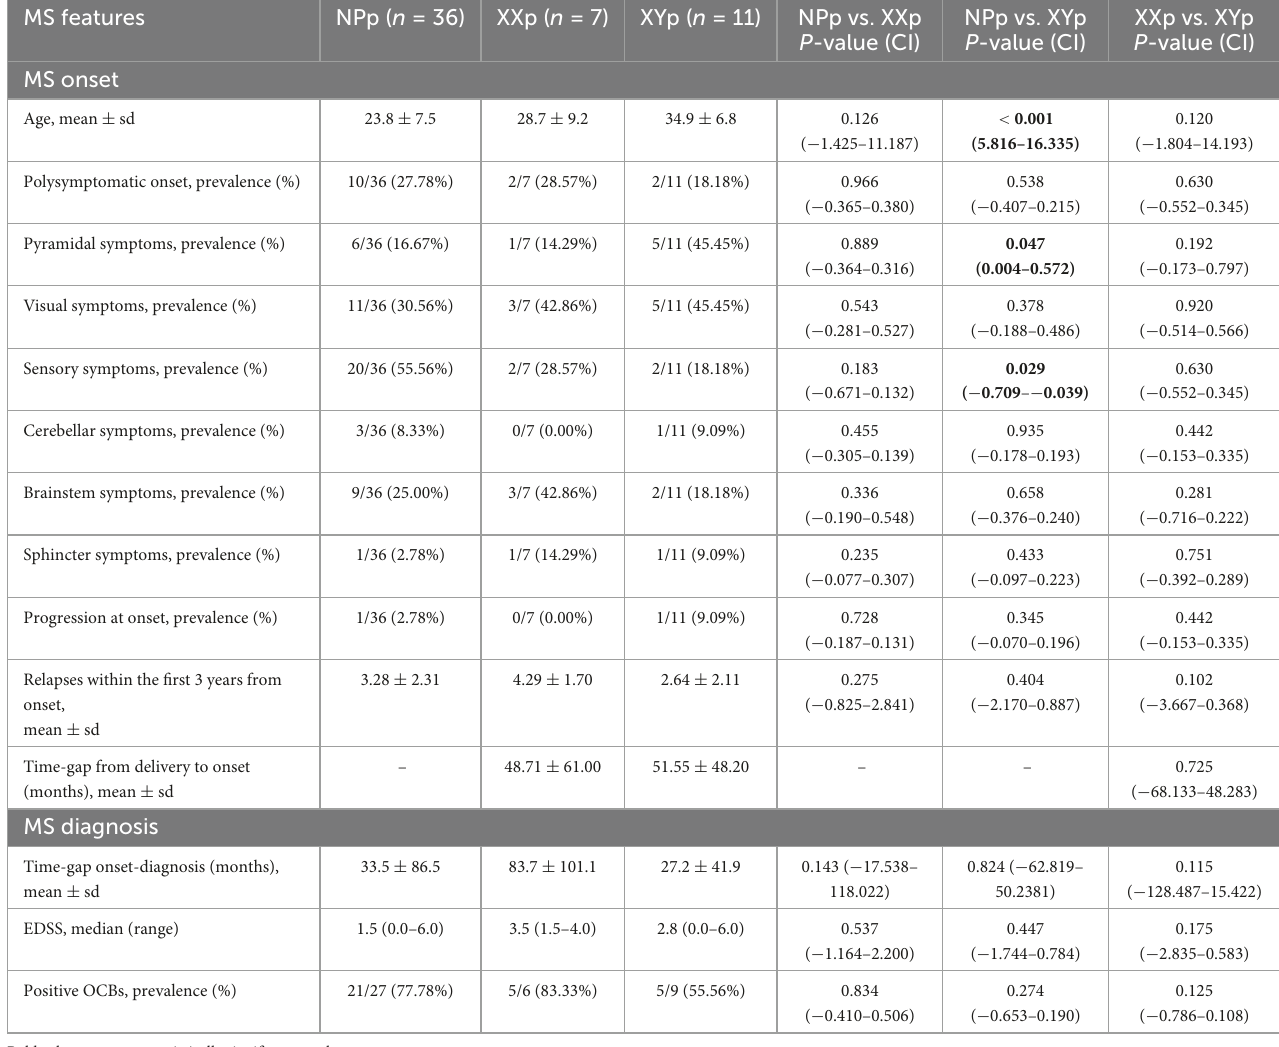
TABLE 3 Comparison of MS features at onset and